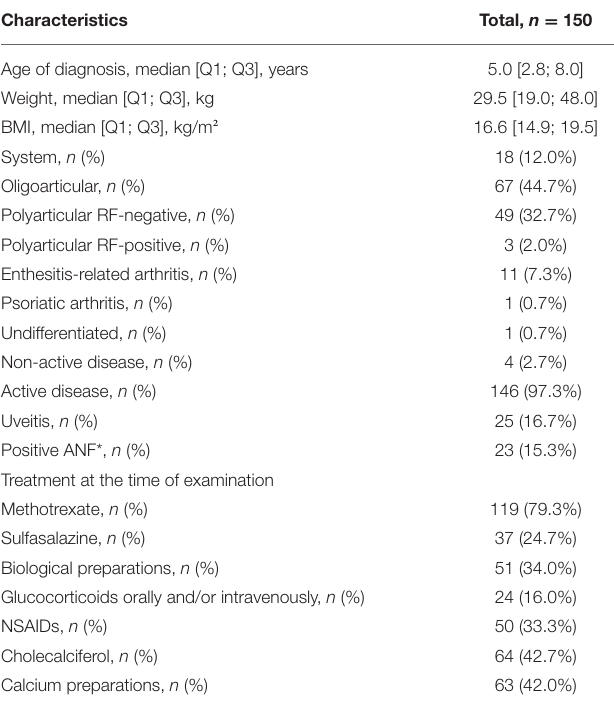
TABLE 4 | Characteristics of patients in the JIA